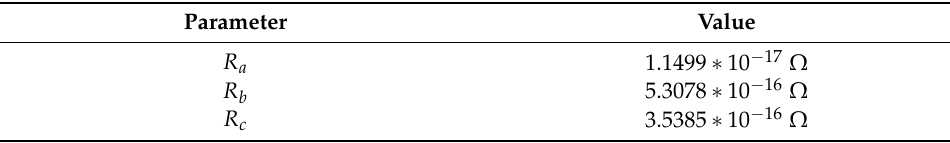
Table 6. Capacitive–Resistor Model’s Parameters (h, 2 r).